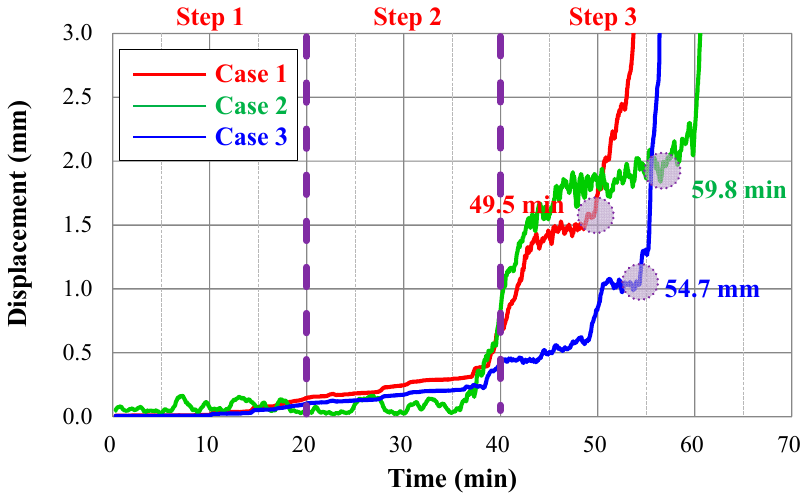
Figure 8. Displacement over time during slope cutting experiment of the model slope.